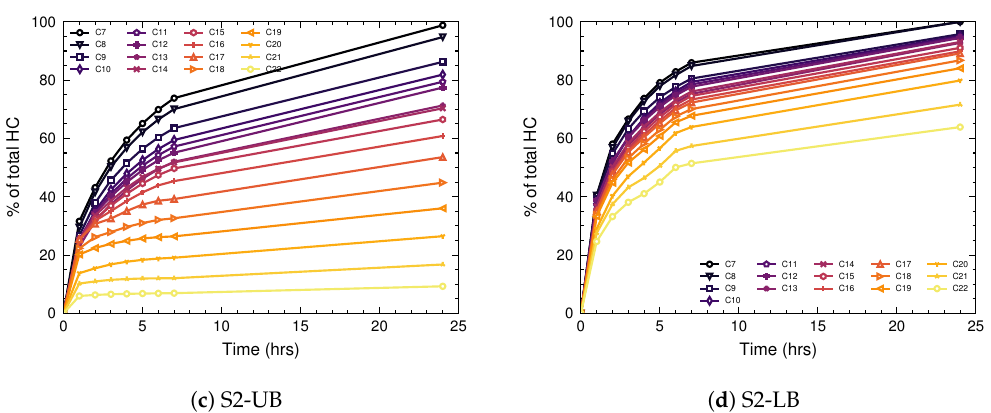
Figure 11. The recovery factors of the individual hydrocarbon components, which were analyzed using GC over the 24-h